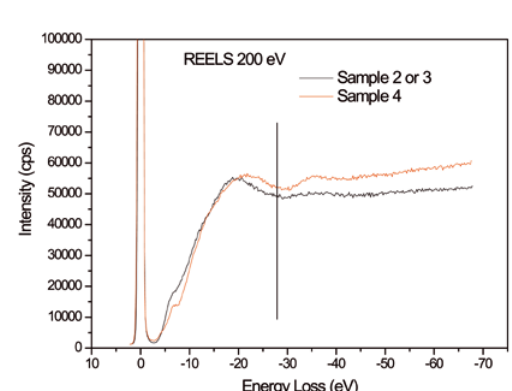
Figure 10. Sn Auger peaks of amalgam surface in Samples 2, 3 and 4 Hg traces have not been detected by XPS (Fig. 8).